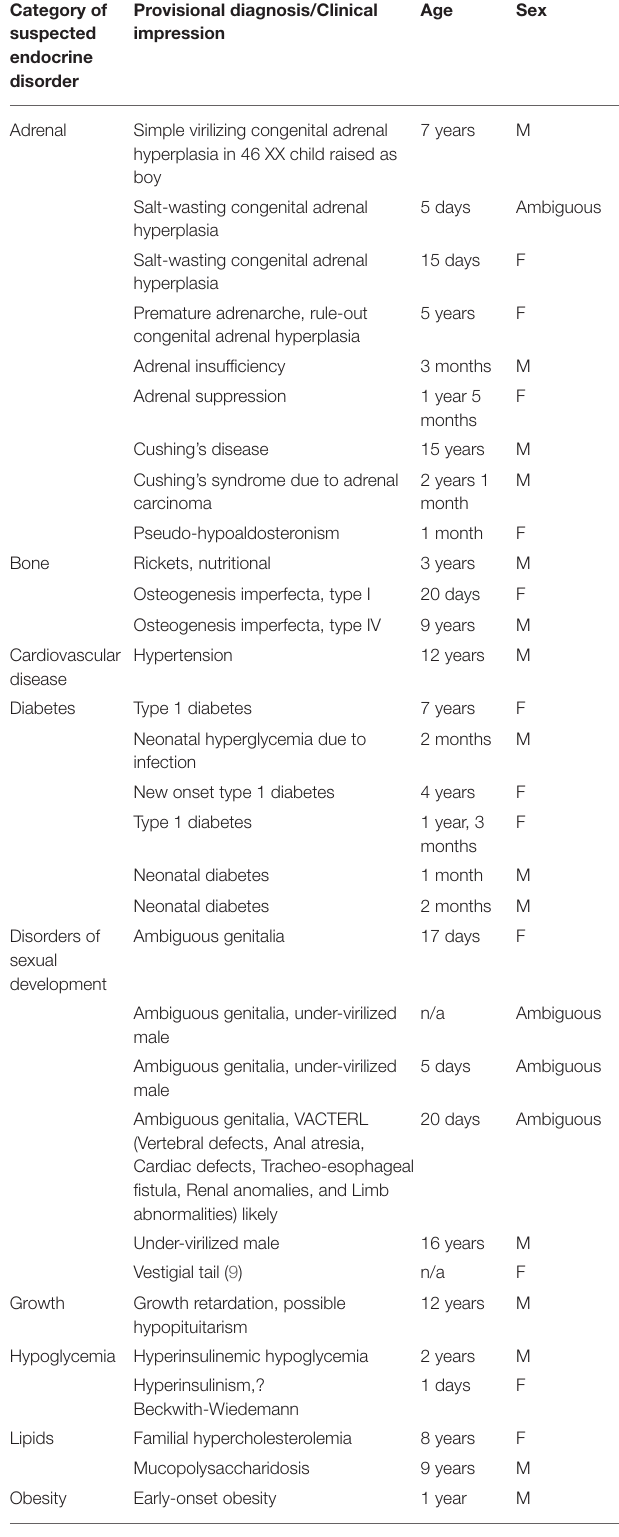
TABLE 4 | Provisional diagnoses of referred patients by category of suspected endocrine